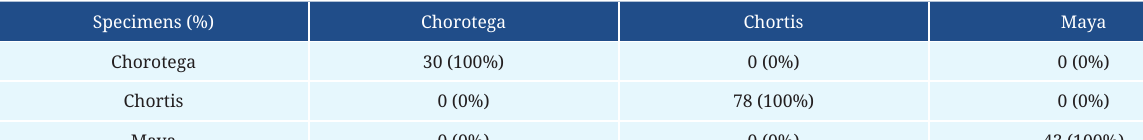
TABLE 2 | Cross validation results for group assignment after CVA.